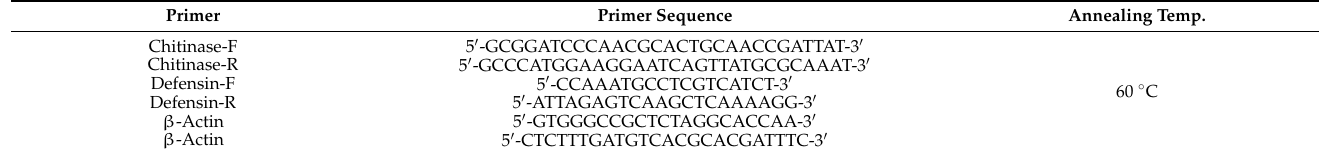
Table 1. Primers used for qRT-PCR defense gene analysis. Primer Primer Sequence Annealing Temp.